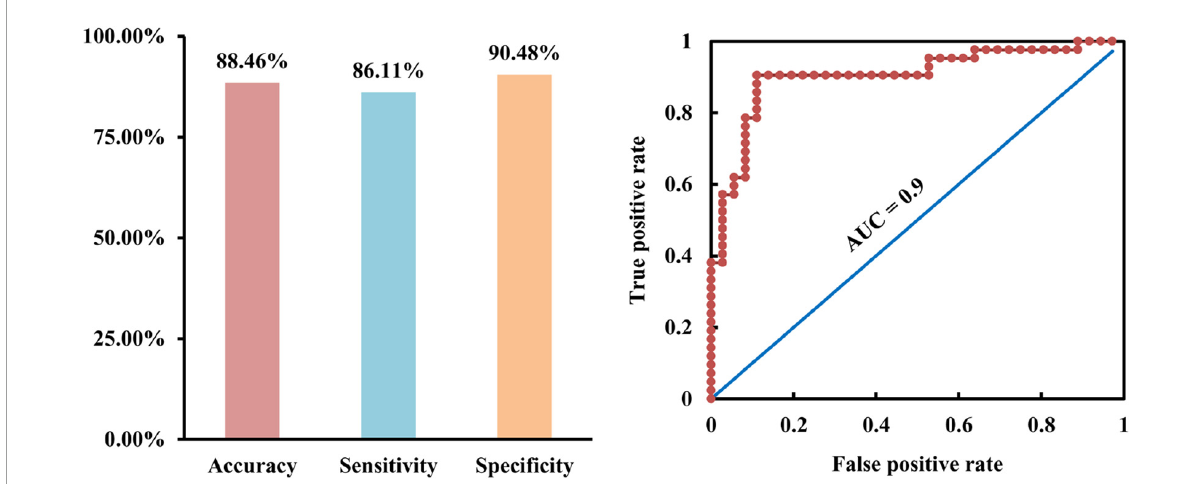
FIGURE3 Classification of Alzheimer’s disease (AD) patients from healthy controls using support vector machine (SVM). With the changed association ability and functional connectivities as features, SVM was used and achieved accuracy of 88.46%, sensitivity of 86.11%, specificity of 90.48%, and area under curve (AUC) of 0.9 for distinguishing AD from healthy controls.